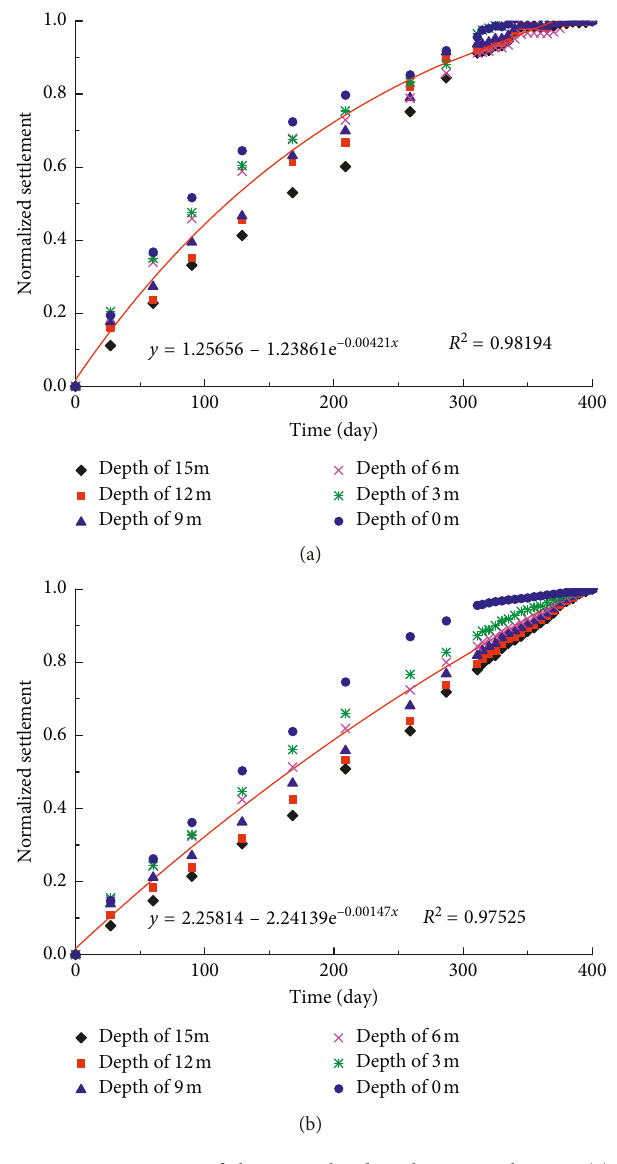
Figure 9: Variation of the normalized settlement with time: (a) road shoulder; (b)